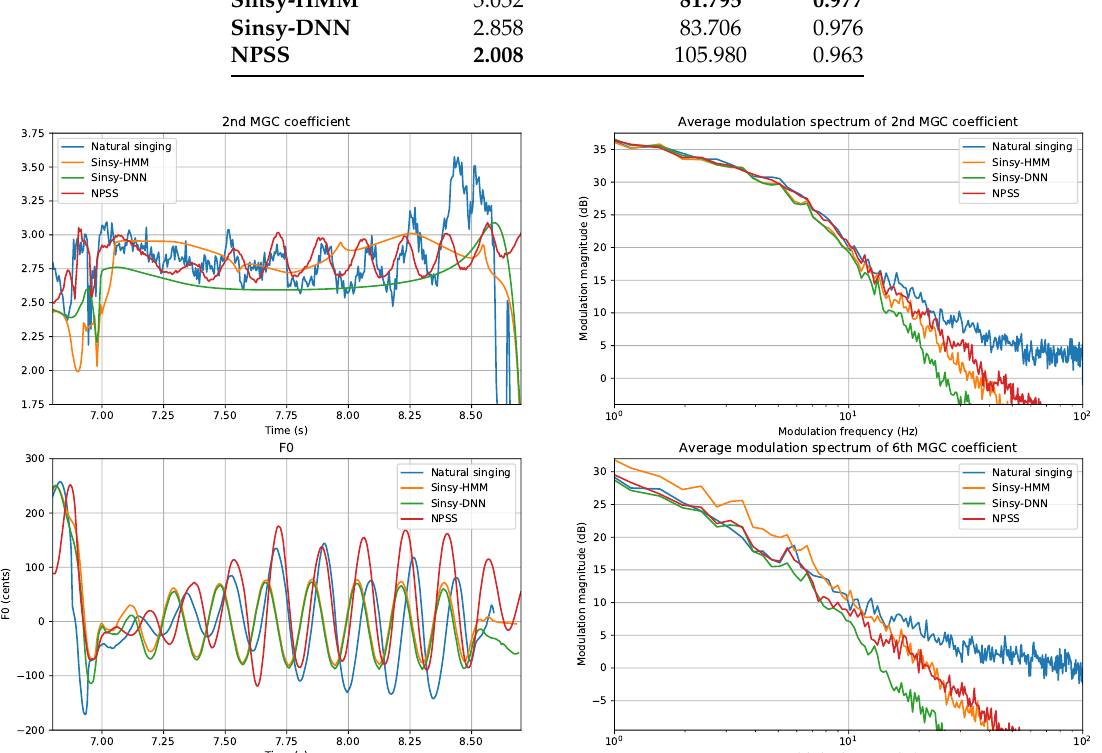
Figure 5. Comparing the average modulation spectrum of harmonic Mel-Generalized Coefficient (MGC) features. In the plotted excerpt, the relation between pitch and timbre during vibratos can be observed.